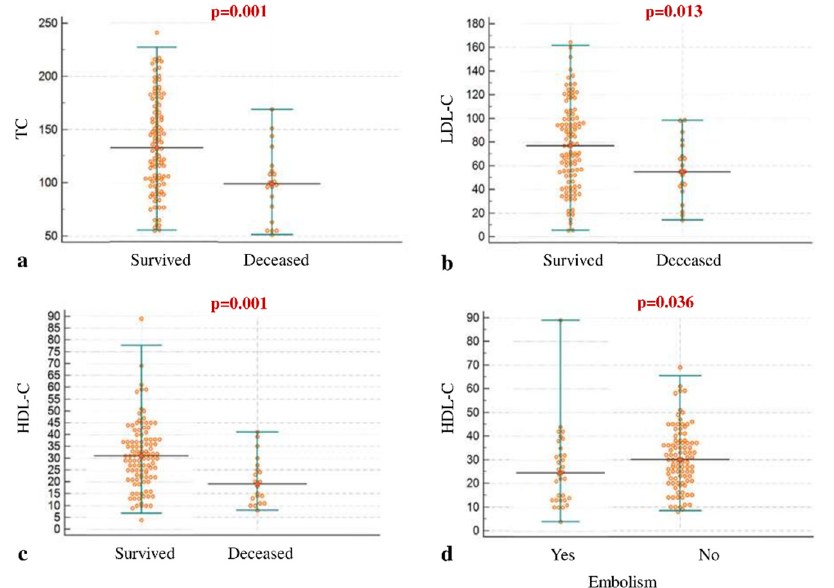
Figure 1. Dot-plot graphs depicting the distribution of total cholesterol ( a ), LDL-C ( b ), and HDL-C ( c ) values in surviving and deceased patients and HDL-C distribution in patients with and without embolic events ( d ). HDL-C, high-density lipoprotein-cholesterol; LDL-C, low-density lipoprotein- cholesterol; TC, total cholesterol. Table 2. Univariable and multivariable analysis of factors possibly associated with IE outcome.